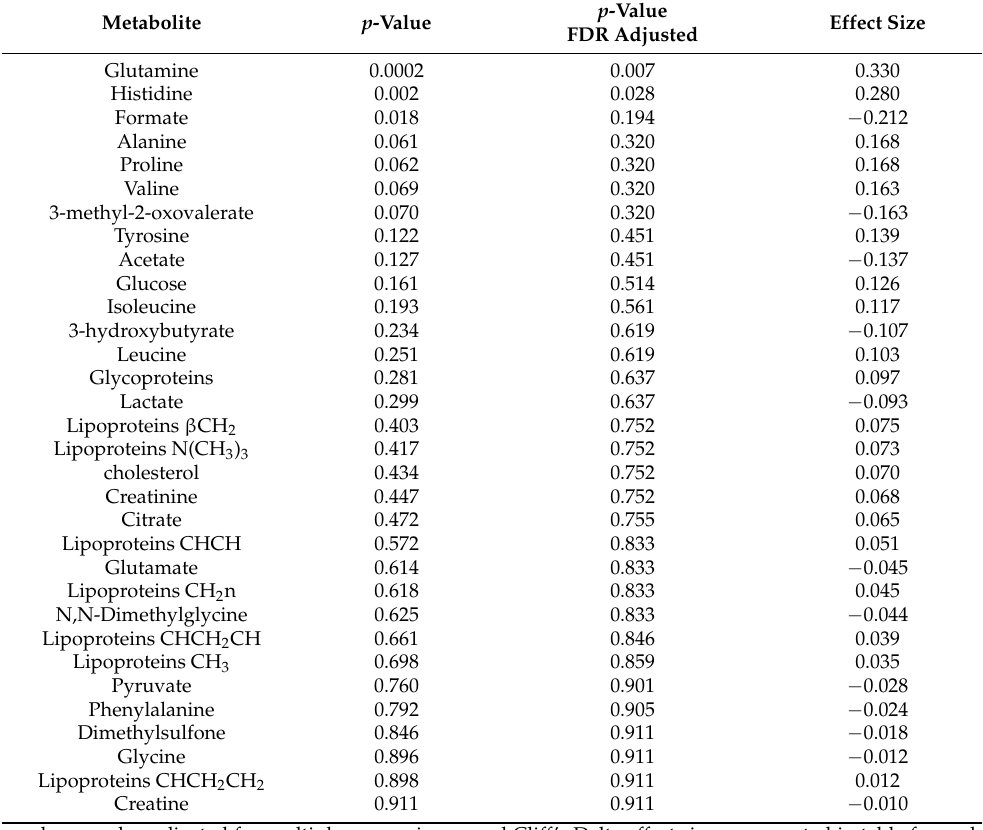
p -value, p -value adjusted for multiple comparisons, and Cliff’s Delta effect size are reported in table for each metabolite. An adjusted p -value < 0.05 is considered statistically significant. Positive effect size means lower levels in mCRC serum samples.